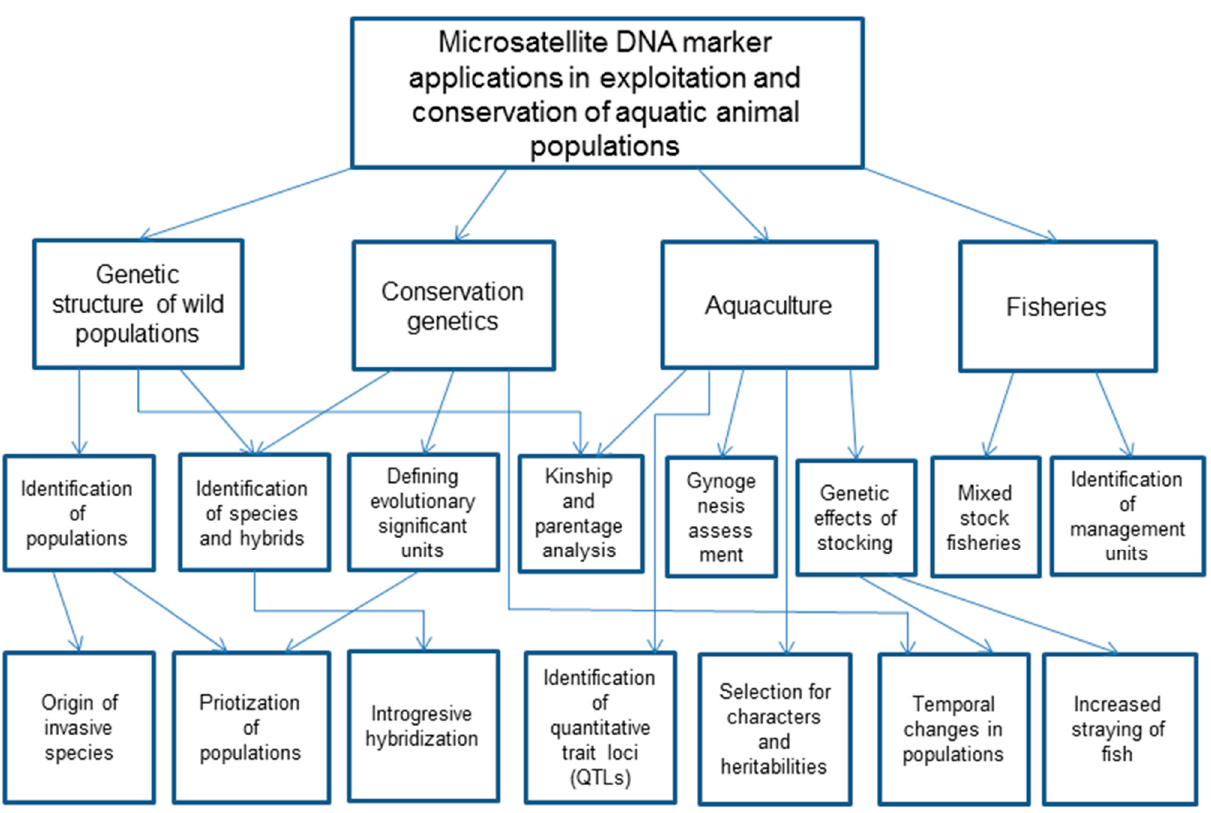
Figure 1. An integrated concept map showing the main fields of applications of microsatellite DNA markers related to aquatic exploited animal populations.